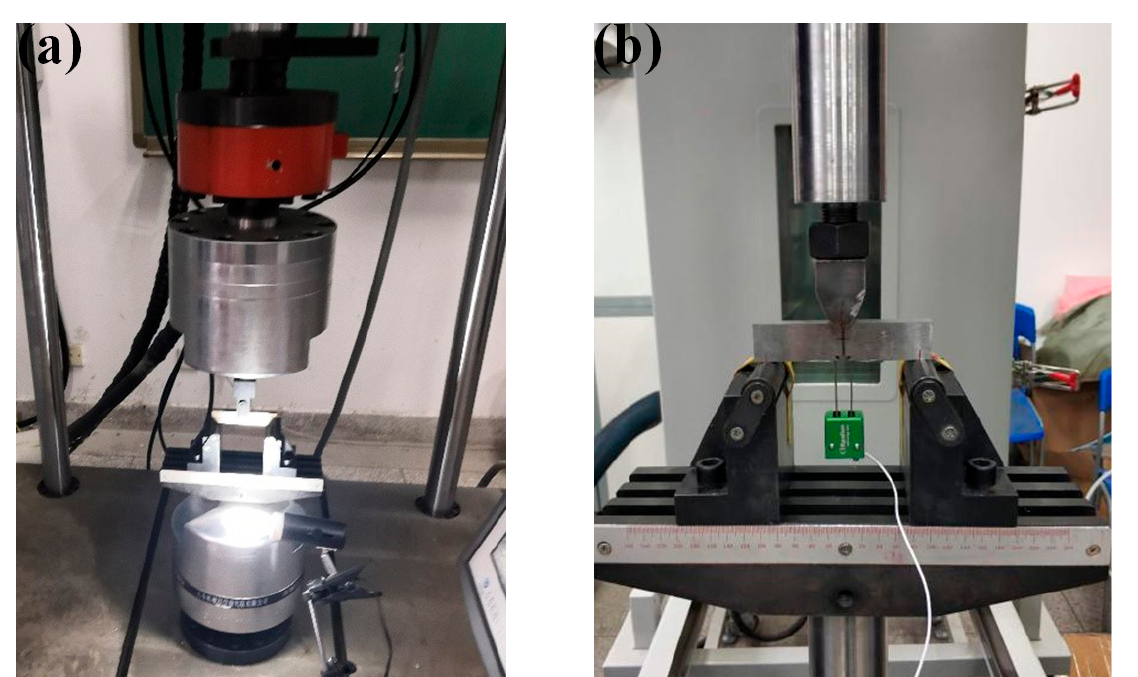
Figure 4. ( a ) Micro pre-crack (0.10 W) was prefabricated in the location of notch tip by an Electro- Hydraulic Servo Fatigue Testing Machine (SDS-300) with a 300 KN load cell; ( b ) three-point bending experiment was performed using an electronic universal testing machine (AGS-X) with a 100 KN load cell. Table 4. Maximum fatigue crack prefabricated forces of four specimens.